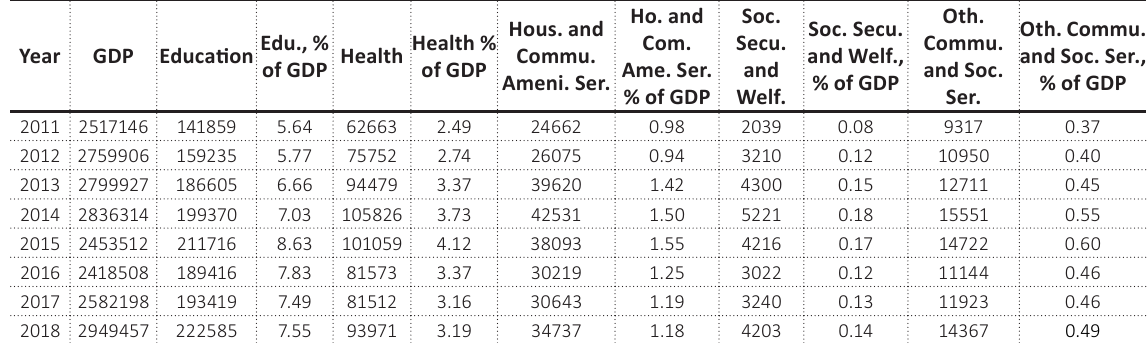
Source: Own calculations based on the absolute values given in Table 1.